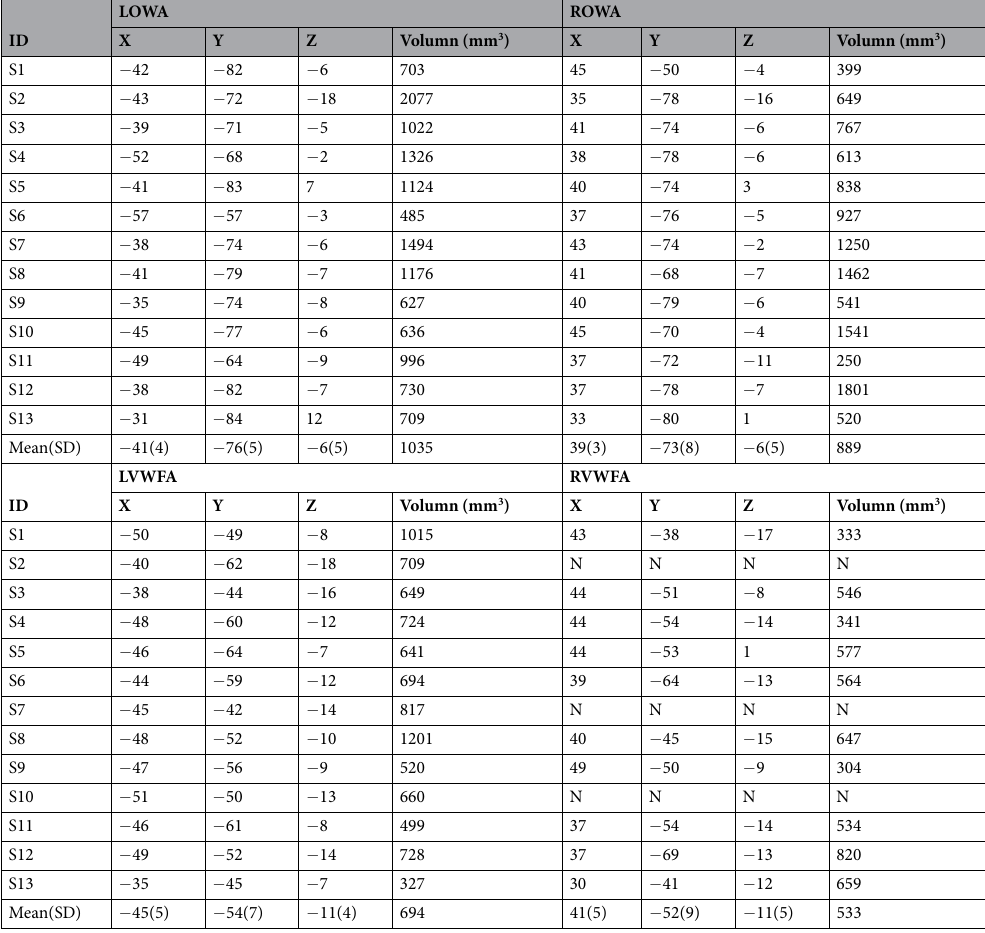
Table 1. Talairach coordinates of center and cluster sizes of ROIs for each subject and mean values across subjects (unit of SD: